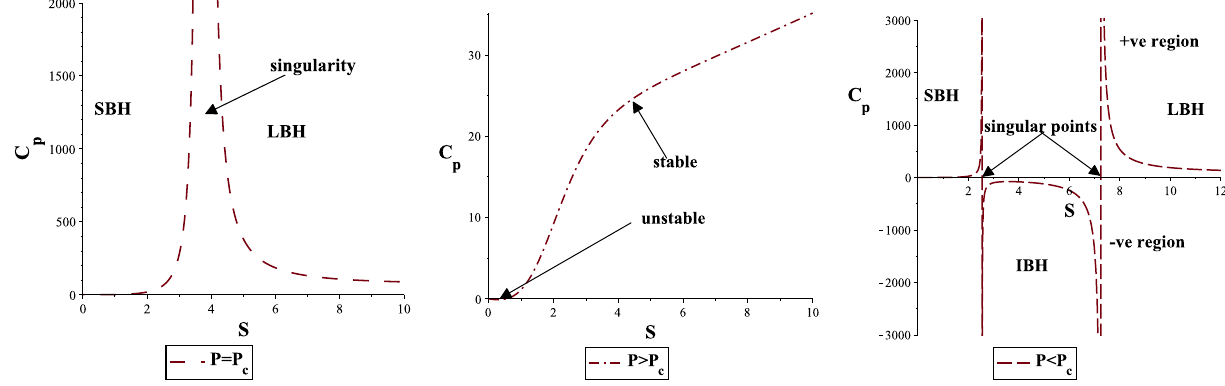
Fig. 10 C p versus S with a 2 = 2, e = 0 . 2 and g = 0 . 6. Left panel: P = P c , middle panel: P > P c and right panel: P < P